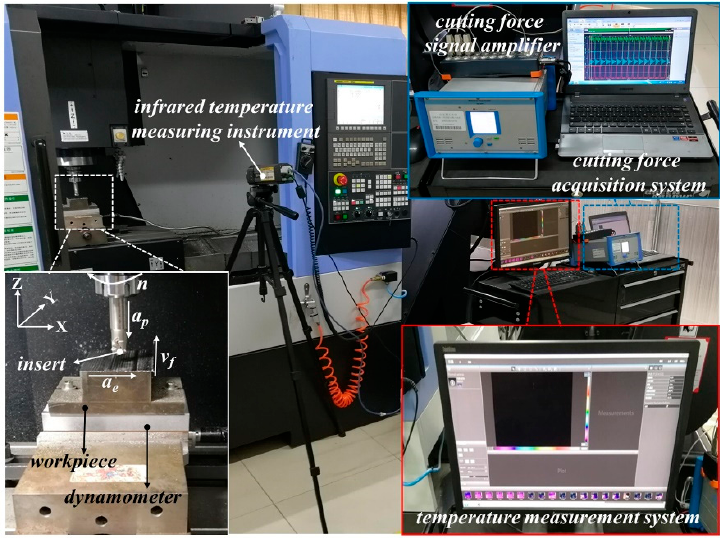
Figure 1. Experimental design of the high-speed milling of AISI 4340 steel.